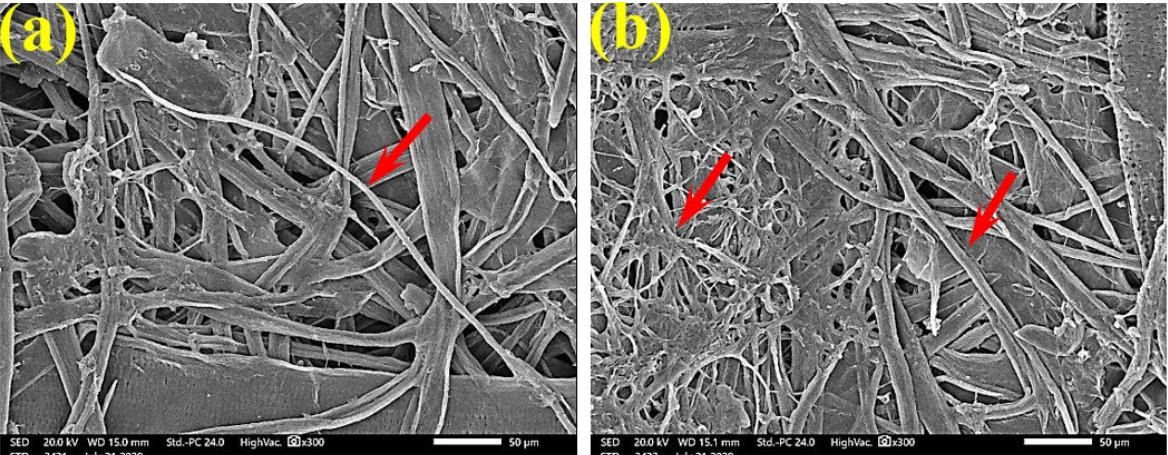
Figure 5. SEM images of the paper sheets manufactured from ( a ) Ficus altissima , ( b ) Sorghum bicolor treated with 0.5% MAHE, and ( c ) Ficus elastica treated with 1% MAHE and inoculated with F. culmorum . Arrows refer to low growth of fungal mycelia based on the concentration of the extract and the type of paper sheet pulp. Figure 6 shows the dense FMG of A. fumigatus on paper discs treated with 10% DMSO (control) made from B. speclabilis (Figure 6a), Ficus altissima (Figure 6b), F. elastica (Figure 6c), Z. mays (Figure 6d), and S. bicolor pulp (Figure 6e). The FMG of A. fumigatus began to decrease following treatment of the paper discs with 0.25% MAHE, as shown in Figure 7. Following treatment with 0.5% MAHE, paper discs made from pulps of B. speclabilis (Fig- ure 8a), F. altissima (Figure 8b), and F. elastica (Figure 8c) showed low FMG of A. fumigatus , as the extract suppressed the FMG of A. fumigatus , and the fibers were more clearly shown. In the SEM examination, FMG of S. solani was clearly shown, with dense growth over the fibers of untreated (control 10% DMSO) handsheets made from B. speclabilis (Figure 9a), F. altissima (Figure 9b), and F. elastica pulp (Figure 9c). FMG was reduced in the treated handsheets treated with 0.25% Z. album extract, but growth was still dense, as S. solani mycelia were found over and between the fibers (Figure 10). Low or even no FMG of S. solani was found when the handsheets were treated with 0.5% MAHE, and weak interconnections of hyphae with the fiber structure of the paper were found (Figure 11). The FMG of S. solani was nearly suppressed (Figure 12a,c) or com- pletely suppressed (Figure 12b) following the application of 1% MAHE to the produced handsheets.